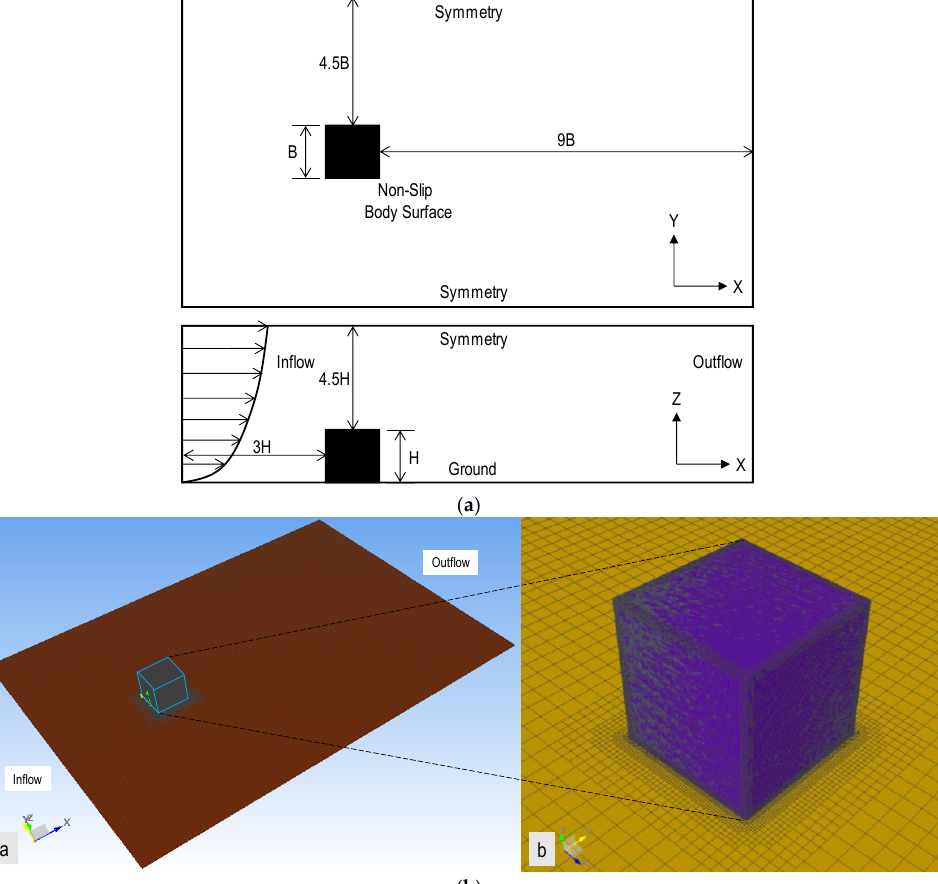
Figure 3. Computational model preparation: ( a ) computational domain and boundary conditions (B = H = 4 m); and ( b ) computational grid: ( a ) whole domain, and; ( b ) cube [17].